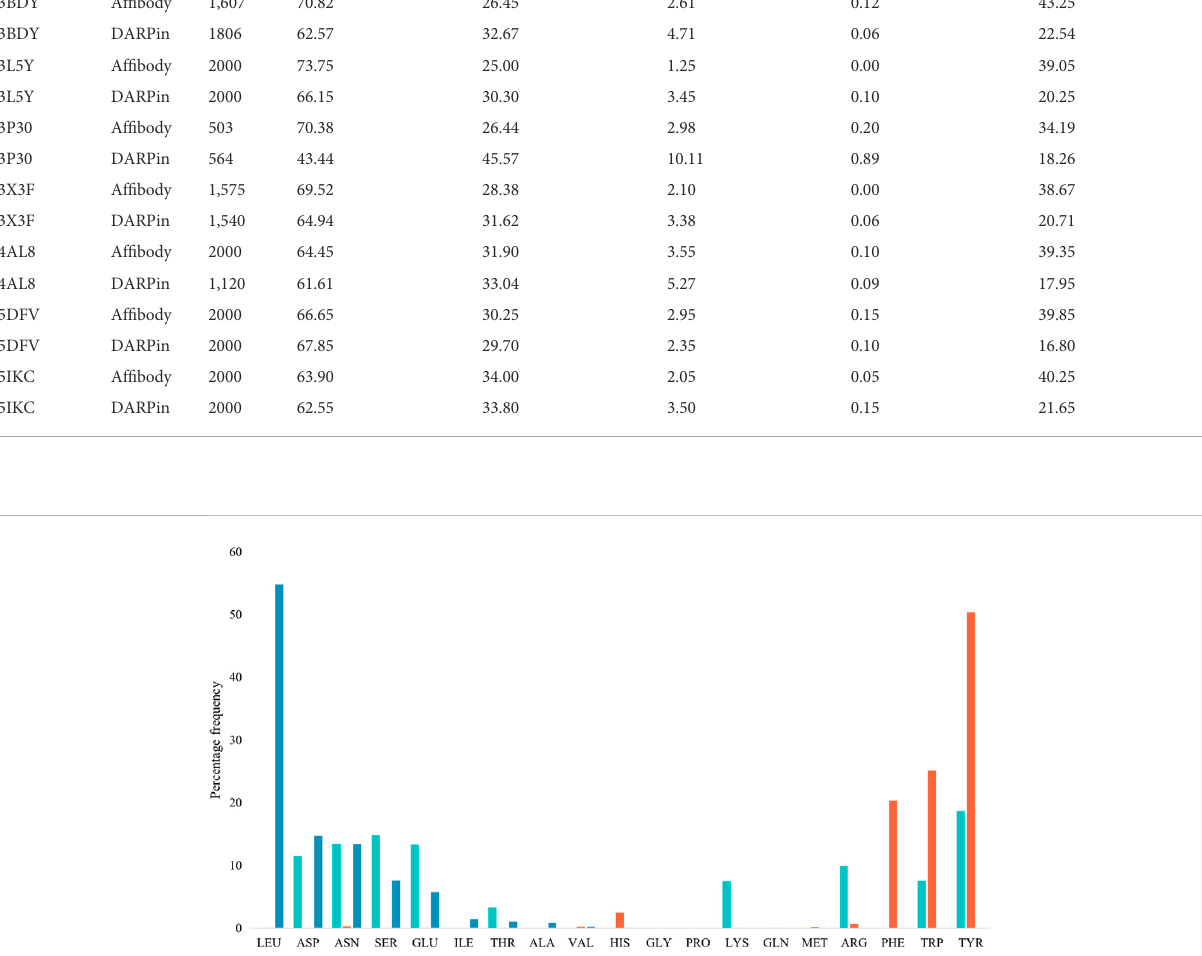
Frontiers in Molecular